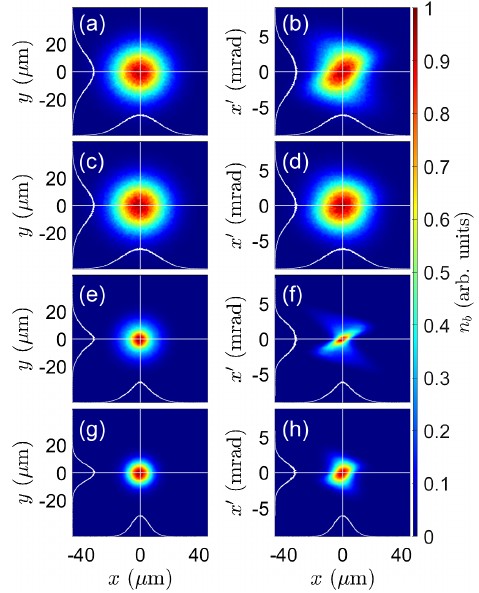
FIG. 9. Electron beam distributions (first column) and hori- zontal phase spaces (second column) at the focal point. (a – b) Initial beam size of 100 μ m. (c – d) Initial beam size of 250 μ m. (a – d) Initial emittance is 10 mm mrad. (e – f) Initial beam size of 100